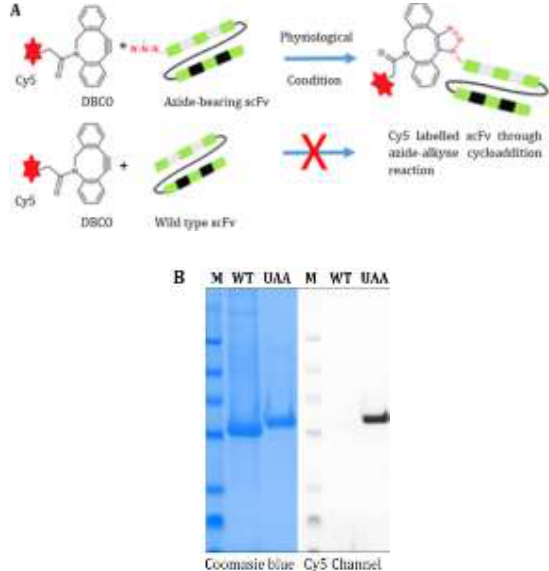
Figure 3. Evaluation of UAA pAzF attachment into a single-chain fragment variable (scFv) of J591 antibody and its binding analysis. A) Copper-free click chemistry reaction of Cy5 labelled DBCO with J591 scFv-pAzF. B) Comparison between J591 scFv wild type and J591 scFv-pAzF in coomassie blue and chemiluminescence Cy5 channel; M: protein marker; WT: J591 scFv wild type; UAA: J591 scFv-